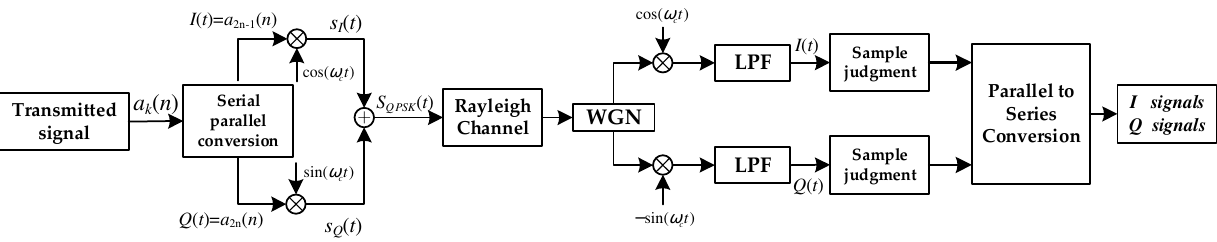
Figure 5. Simulation flow of the QPSK system.